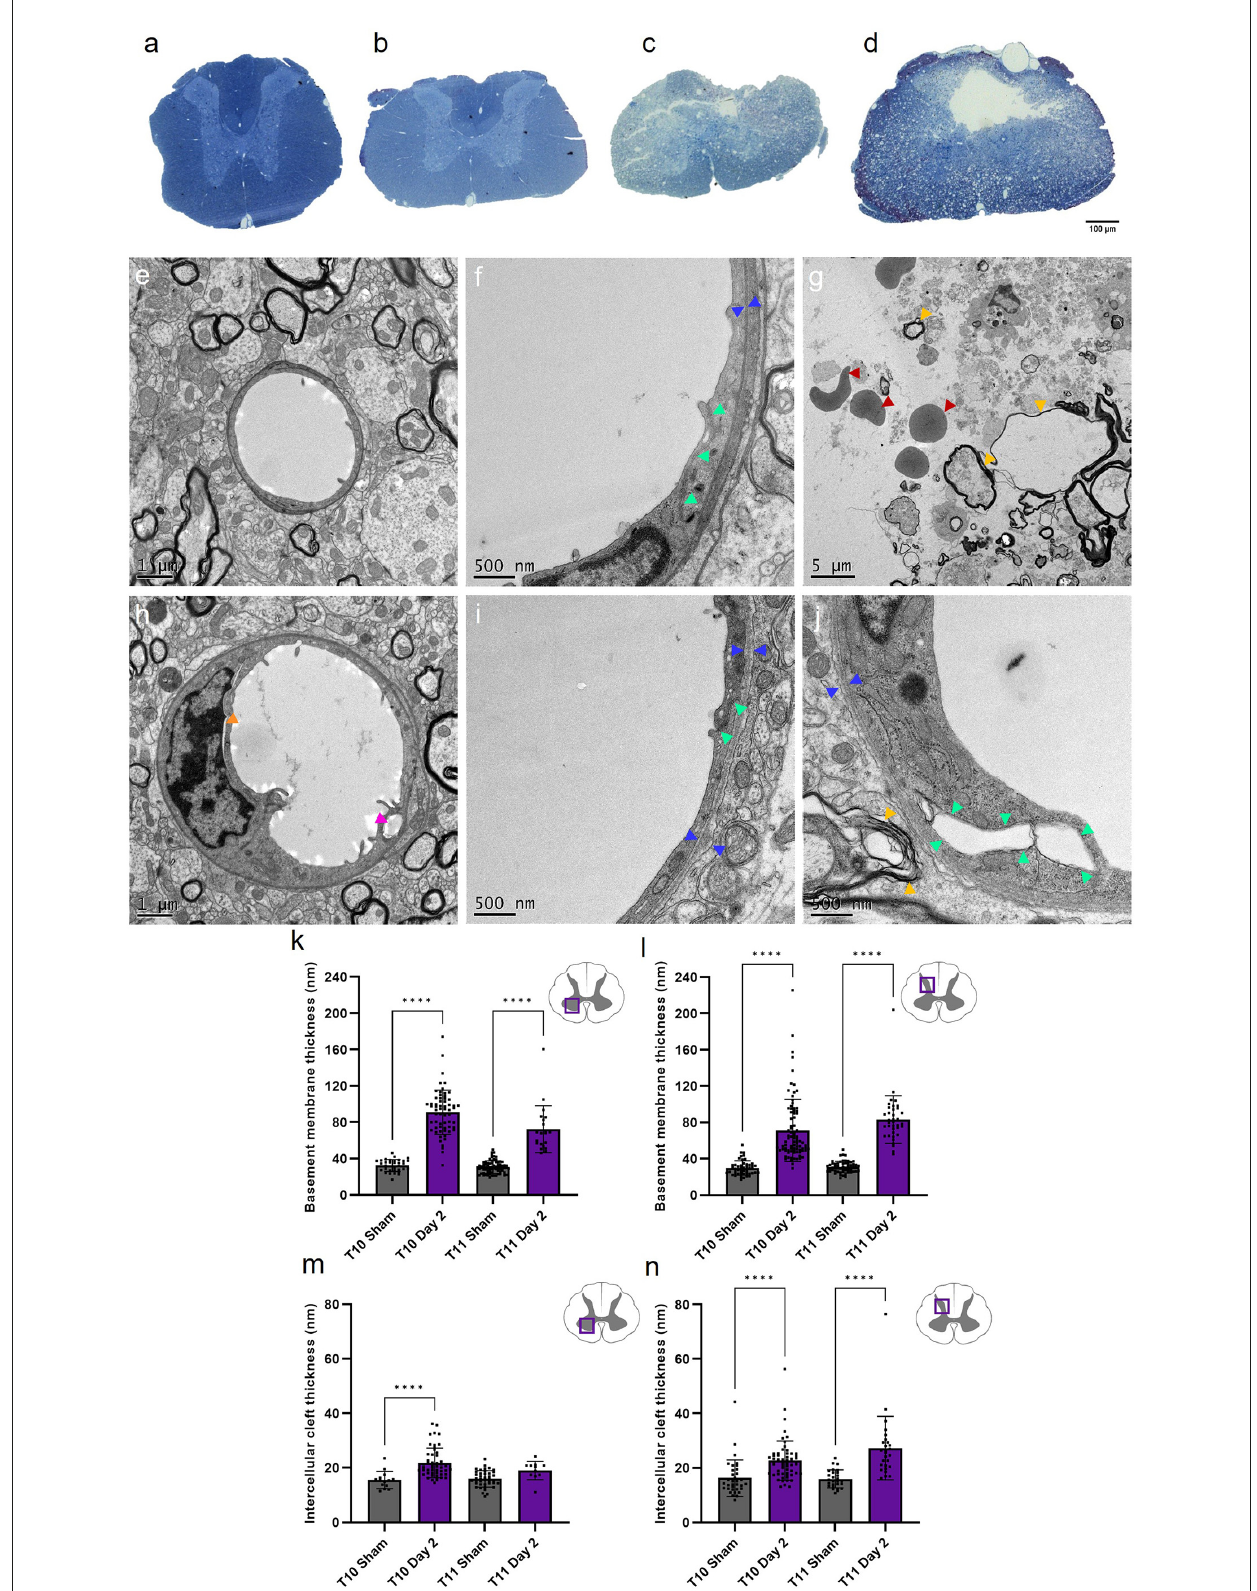
FIGURE6 Transmission electron microscopy (TEM) revealed severe capillary damage at acute time points following spinal cord injury. Semi-thin sections demonstratedtheextentofinjurydamageatday2atT10 (C) andT11 (D) comparedtoshamatT10 (A) andT11 (B) .Shamcapillaries (E,F)